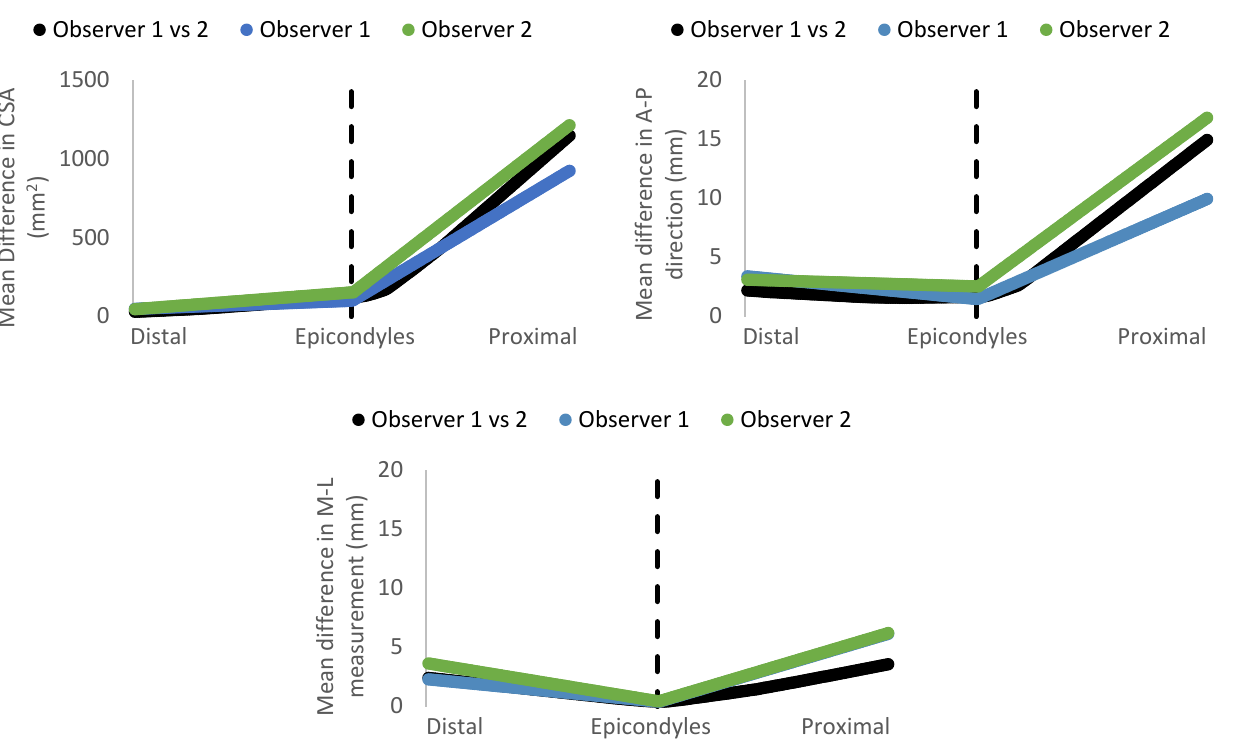
Figure 6. Mean differences in CSA, A-P and M-L measurements within and between observers along the residuum model across 15 participants. The residuum lengths were normalized for each participant to match up the distal and proximal ends, as well as the epicondyles. The dash line indicates the location of the epicondyles.